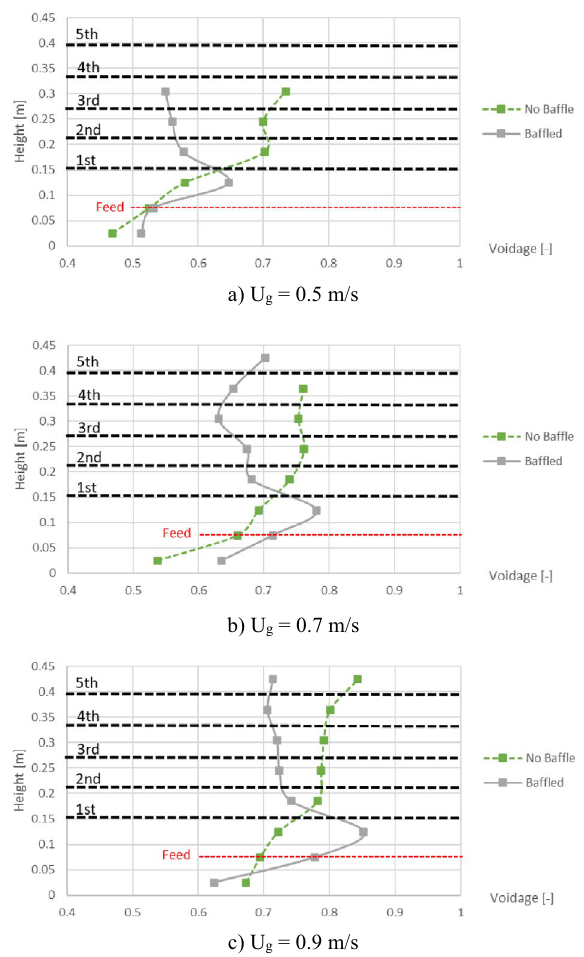
Figure 7. Maximum of cross-sectional averaged voidage in bed before and after installing the baffles, when operating at various gas inlet